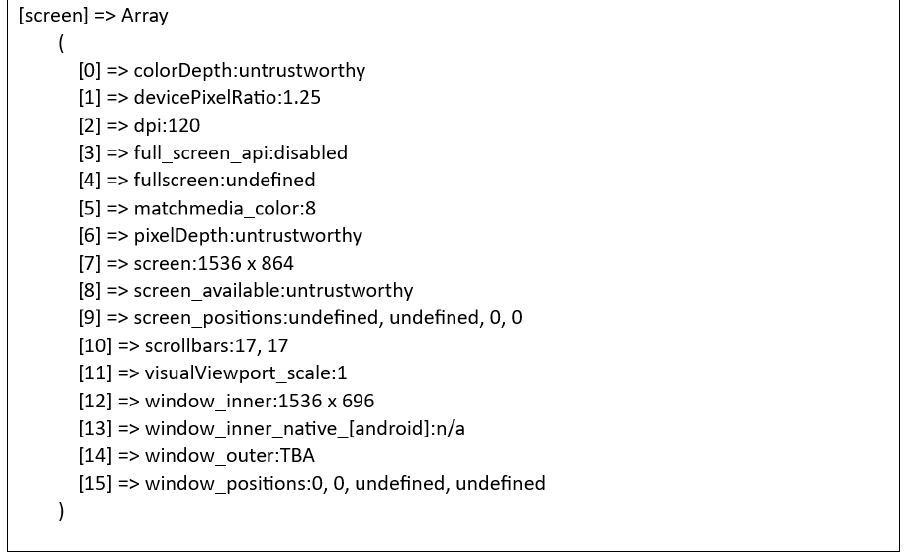
Figure 7. Example of screen attributes data collected in a text file.